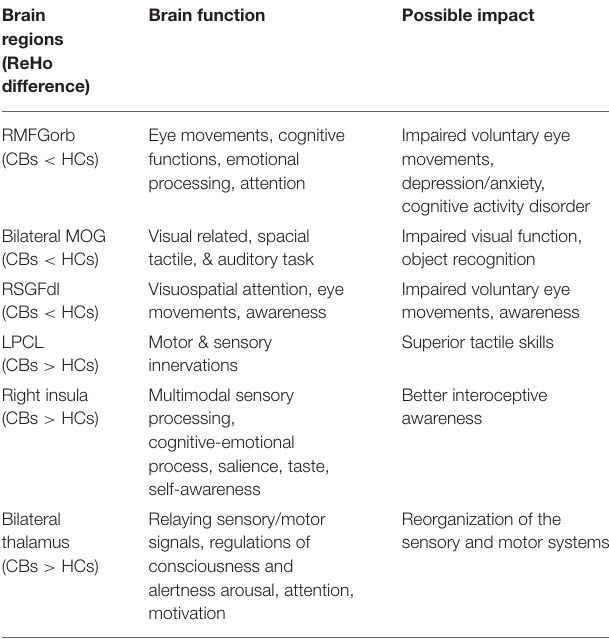
TABLE 6 | Altered brain regions and their potential